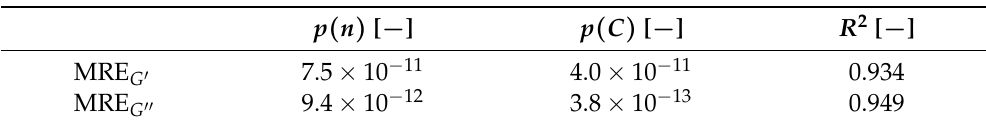
Table 7. p -Values of the slopes and intercepts and R 2 -values for a linear scaling of log MRE Ref log G (cid:48) in Figure 10, as described by Equation